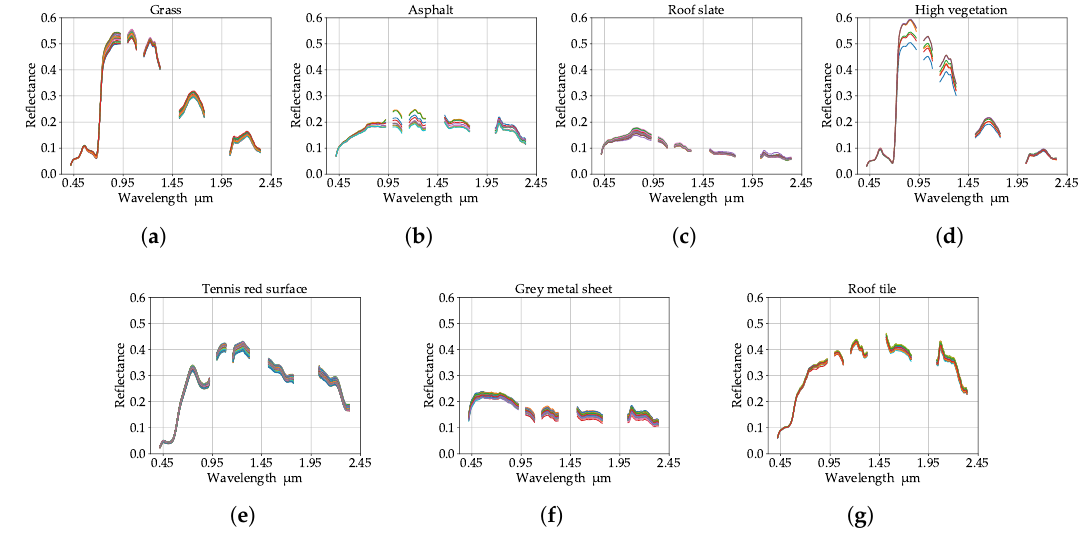
Figure 4. Reference spectra used to build the synthetic images. The material classes are: ( a ) grass, ( b ) asphalt, ( c ) roof slate, ( d ) high vegetation, ( e ) tennis red surface, ( f ) grey metal sheet and ( g ) roof tile. The simulation of the 2 m GSD Top-Of-Atmosphere PAN image is done as follows: first, an atmospheric model, using COMANCHE, is applied on the 2 m GSD ground reflectance HS image in order to have a 2 m GSD TOA radiance HS image. Secondly, a HS noise component, considering the HYPXIM noise model is then added using Equation (24). Finally, a spectral binning using a square window from 0.4 µ m to 0.8 µ m is performed to obtain the 2 m GSD PAN image. The resulting synthetic data set is shown in Figure 5.